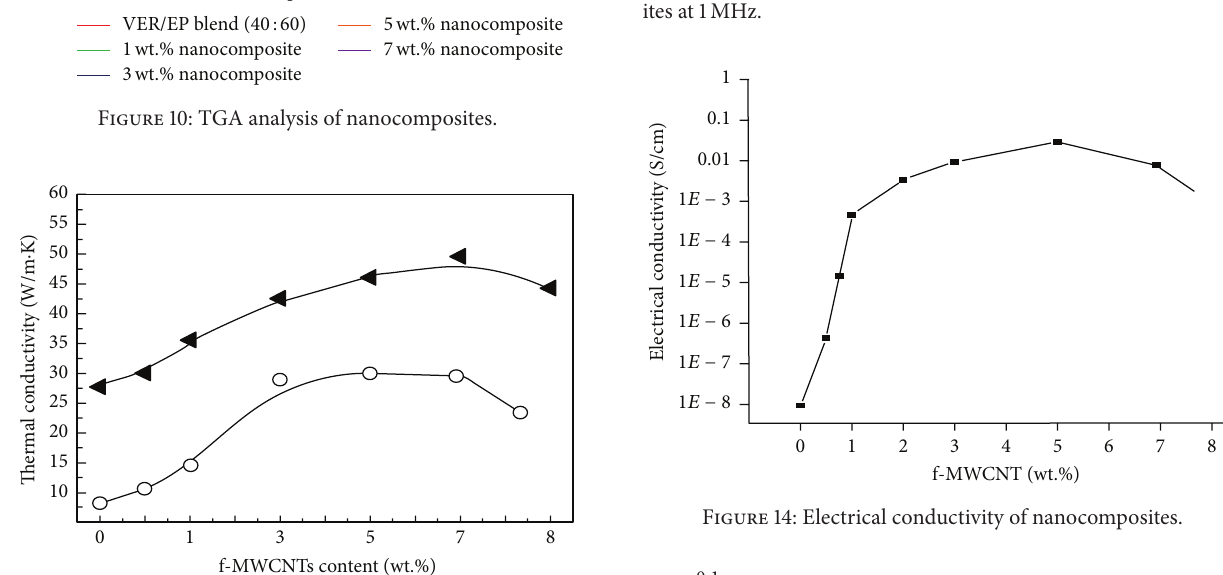
Figure13:Effectoff-MWCNTsondielectricconstantnanocompos- ites at 1MHz.